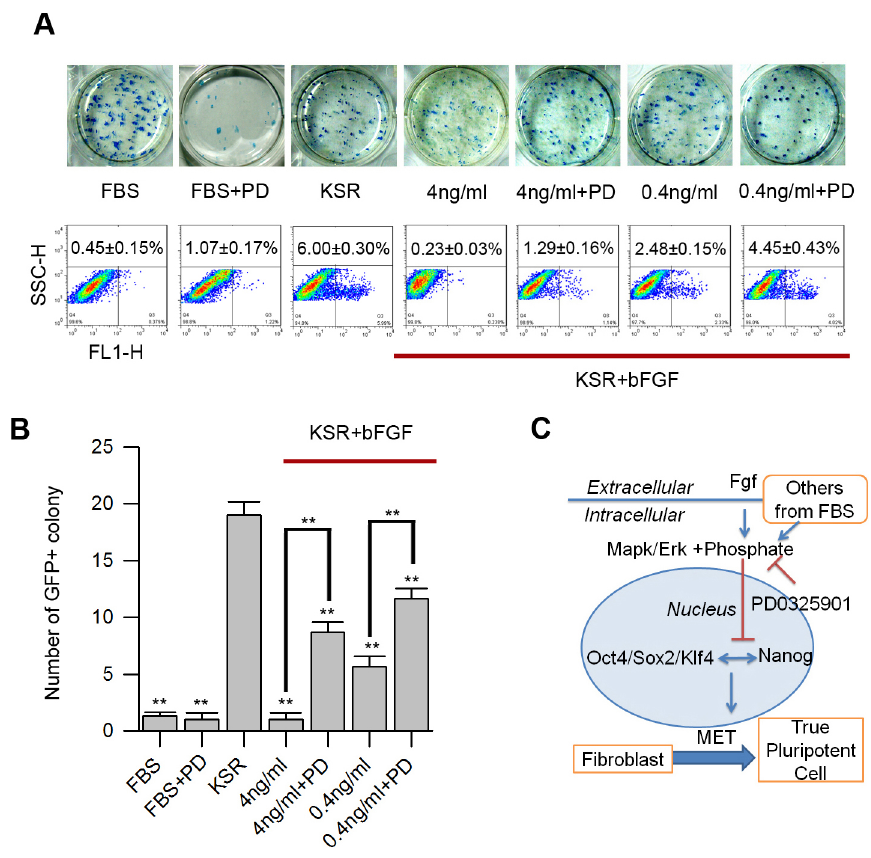
Figure 6. PD rescues repressive effect of bFGF in iPS cell induction. (A–B) Comparison of primary iPS cells derived from adult fibroblasts among different induction media on day 12 using different assays, including AP staining (A upper), the percentage of Nanog-GFP + cells by FACS (A lower), and the number of Nanog-GFP + colonies by fluorescence microscope (B). The induction media were FBS based and FBS with PD medium (FBS + PD); KSR medium and KSR medium with small molecules, including bFGF (4 ng/ml), bFGF (4 ng/ml) + PD, bFGF (0.4 ng/ml), and bFGF (0.4 ng/ ml) + PD, respectively. (C) Functional model of MAPK/ERK pathway in the induction process. FGF may be one of the barriers in FBS that blocks formation of high-quality iPS cells. PD0325901, which selectively inhibits the MAPK/ERK pathway, benefits activation of Nanog and pluripotent endogenes during reprogramming.